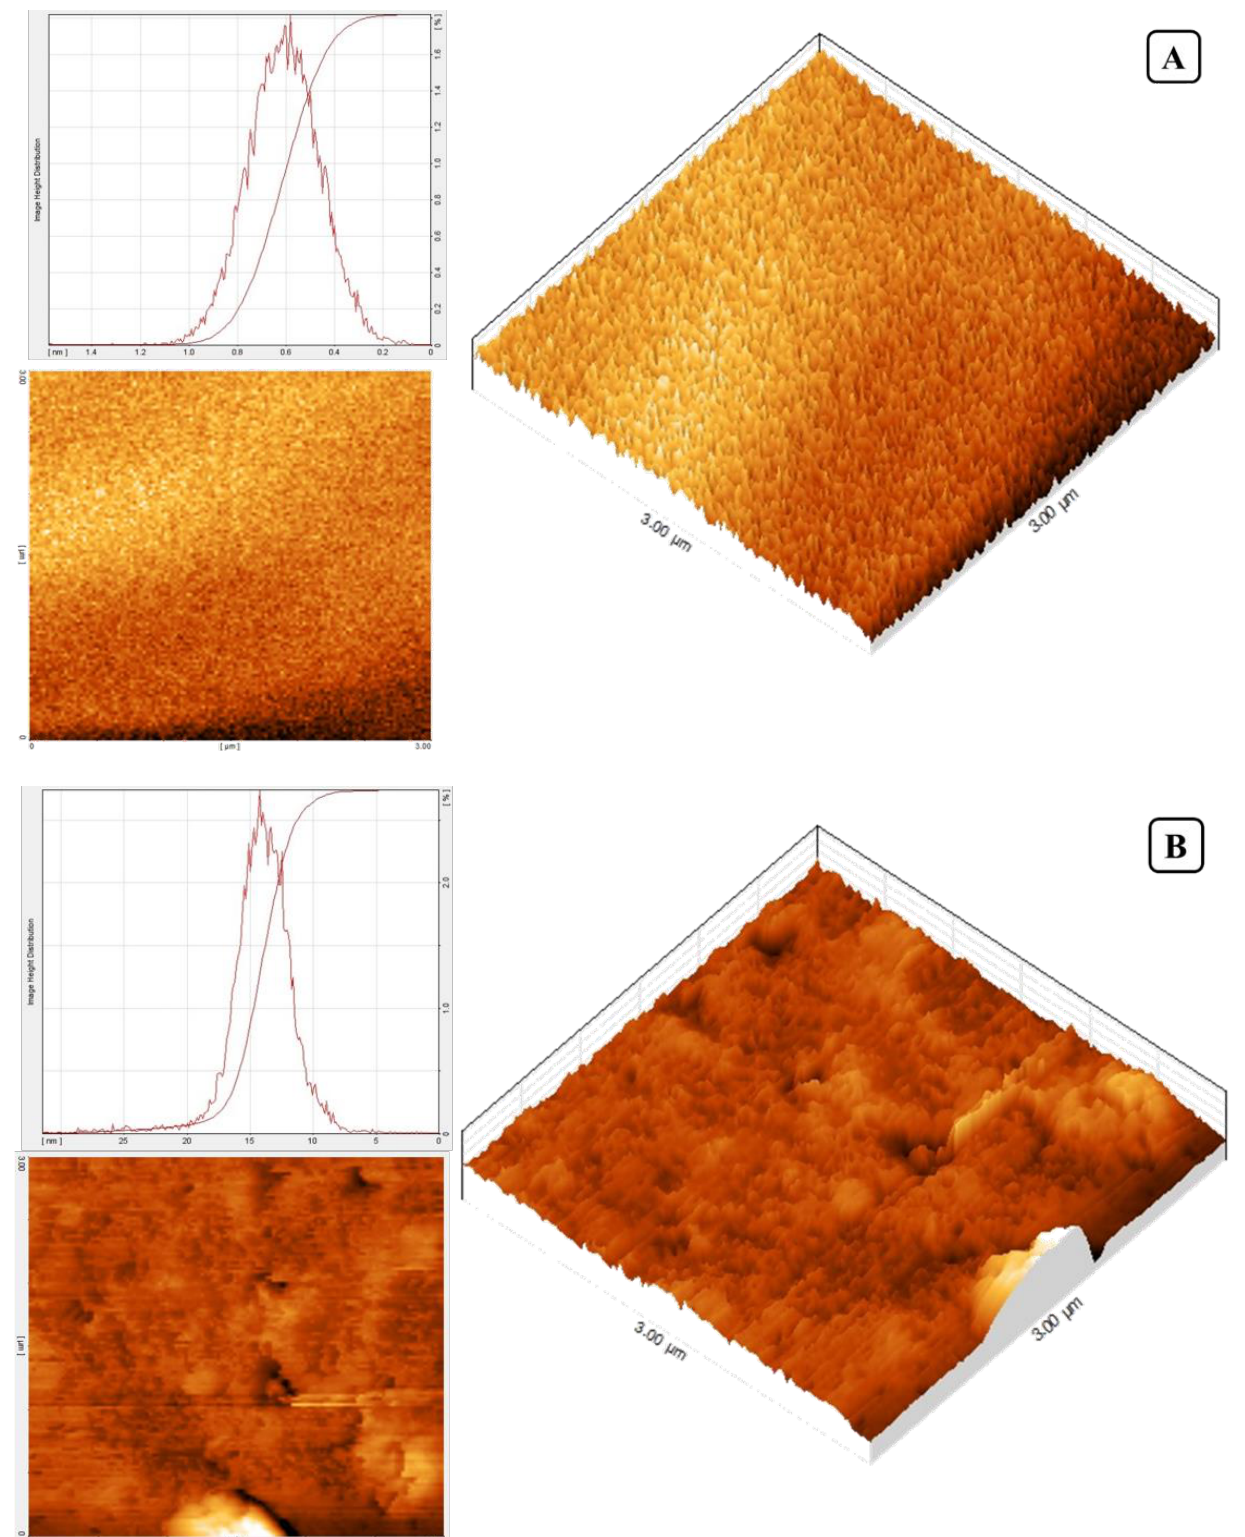
Figure 6. AFM 2D/3D images and height distribution of salep mucilage edible ( A ) control and ( B ) indicator films (5% v / v SA As ). ( B ) indicator films (5% v / v SA As